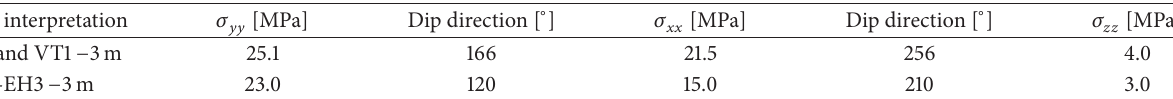
Table 2: The in-plane stresses below the tunnel at experiment hole location.